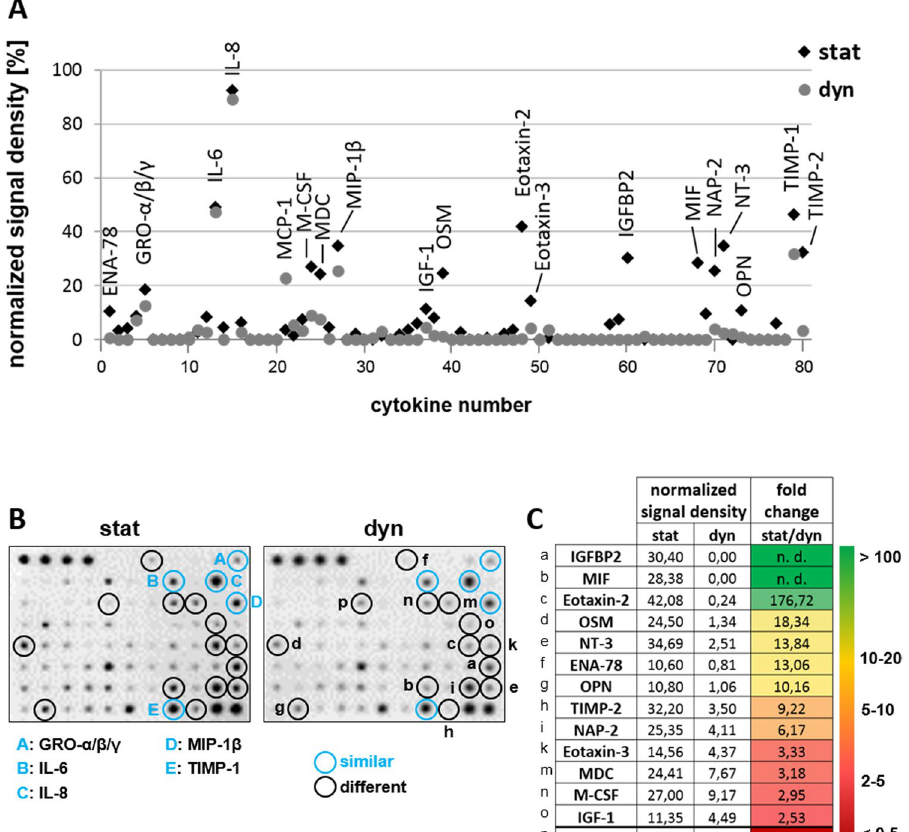
Figure 5. Hydrogels in static culture accumulate higher concentrations of cytokines than in dynamic conditions. The abundance of cytokines within macroporous hydrogels after 9 days of static or dynamic culture was analyzed with a human cytokine antibody array. ( A ) Normalized signal densities for individual cytokine antibody arrays probed with medium recovered from hydrogels after 9 days of static or dynamic culture. Marks with the same position on the x-axis represent signals for the same cytokine in both arrays. Marks of spots eliciting 10% signal density or more are labeled with the respective cytokine name. Black marks: cytokines within medium from static hydrogels, grey marks: cytokines within medium from dynamic hydrogels. ( B ) Optical images of the antibody arrays probed with medium from static or dynamic culture. Mode of culture is given at the top. Black circles identify cytokines with differential abundance in static and dynamic conditions. Blue circles identify cytokines that are present to similar levels in both samples. Corresponding cytokine names are given at the bottom or in the table in (C). ( C ) Summary of all cytokines that were identified to be present at different levels in static and dynamic culture inside the hydrogels. The table gives the raw values of normalized signal densities for individual cytokines in the static and dynamic culture as well as the resulting fold change stat/dyn. The letter code on the left assigns the cytokines to their corresponding location on the array shown in ( B ). The color code on the right gives a rough estimate of the abundance of the respective cytokines in the static to the dynamic culture; from dark red (fold change < 1) to green (fold change > 100, or not determinable (n.d.), as the cytokine is only present in the static culture